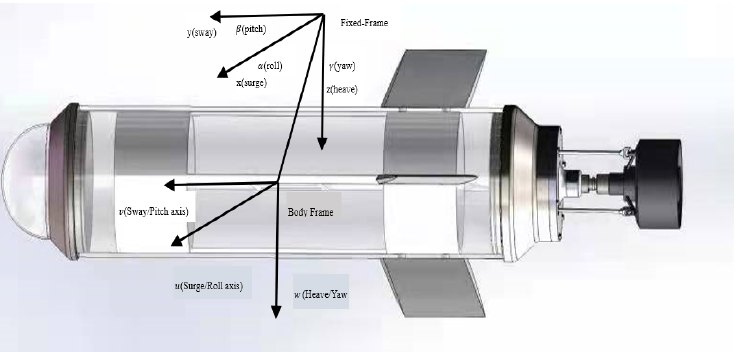
Figure 2. Body-fixed frame and earth-fixed reference frame for underwater